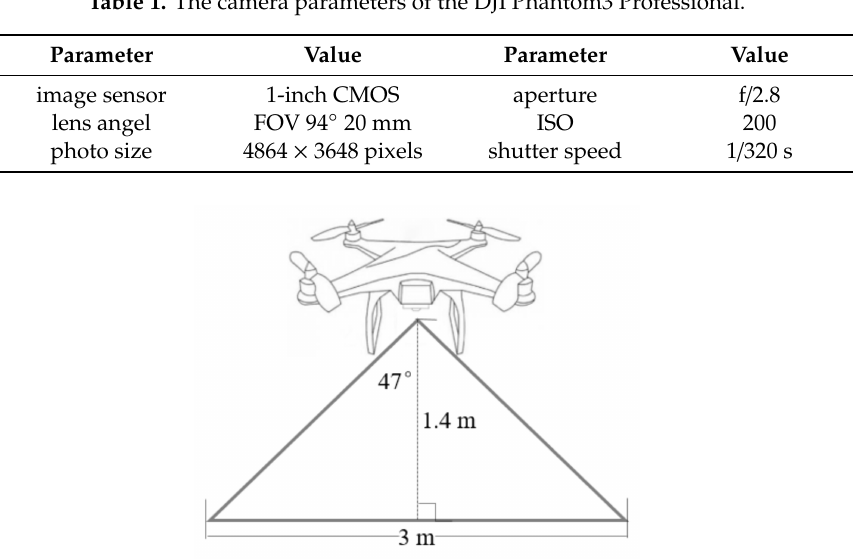
Table 1. The camera parameters of the DJI Phantom3 Professional.